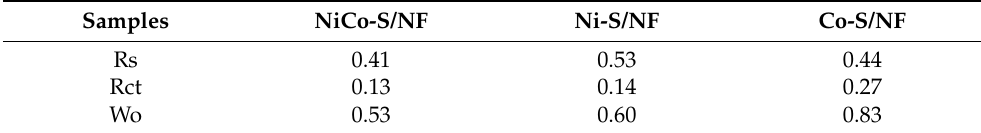
Table 2. Parameters of the equivalent circuit mod.